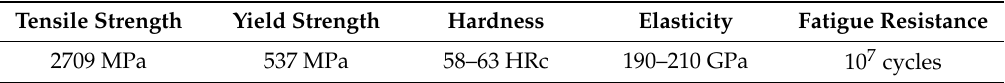
Table 1. Prescribed mechanical properties of AISI 1085 steel wire.